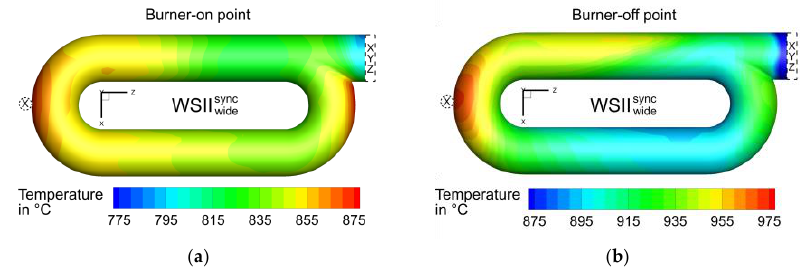
Figure 8. Temperature distributions at the burner-on ( a ) and-off ( b ) points for case VI.